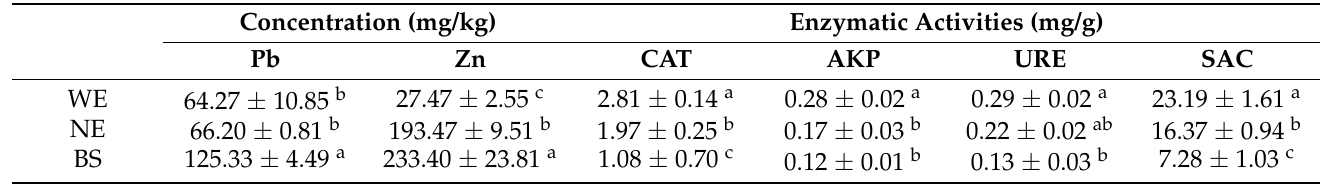
Table 1. Heavy metals and enzymatic activities of rhizospheric soil under different